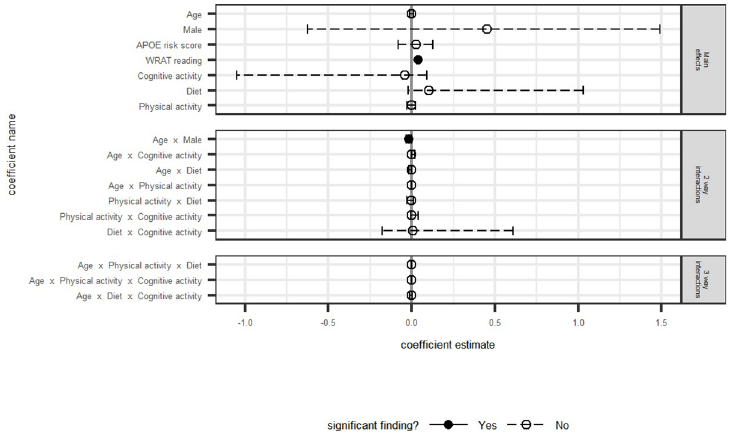
Fig 3. Delayed memory: Model averaged regression coefficient estimates and 95% confidence